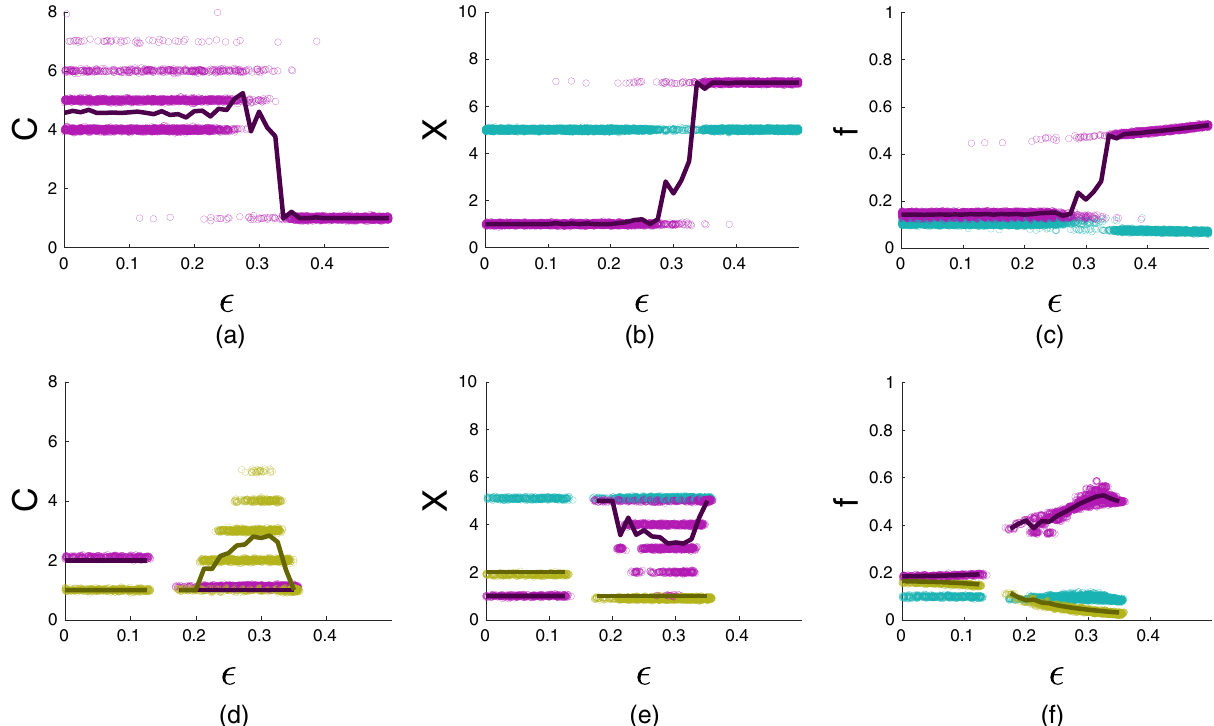
Figure 2. Effects of the incumbency parameter ε on the number of cooperating groups C ( a , d ), the number of cooperating individuals per group X ( b , e ) and group power f ( c , f ). First row of graphs: equilibria with just one type of cooperating groups. Defecting groups are shown in blue symbols. Second row of graphs: equilibria with dominant (violet symbols) and subordinate (golden symbols) cooperating groups. Curves show the average values of corresponding characteristics. The equilibria illustrated in the top and the bottom rows are simultaneously stable. Eight groups of the same size n = 10 . Other parameters: b 1 = 20 , b 2 = 10 , α = 1 , c = 1 , π 0 = 1 , X 0 = 5 , Z 0 = 50 , µ 1 = µ 2 = 0.25 . The results shown are based on 200 runs with 4000 time steps for each parameter combination. The outcomes for each run are averages of the last 1000 time